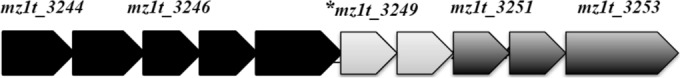
Physical map of the putative polysaccharide deacetylase genes located in the MZ1T EPS cluster (mz1t_3244, polysaccharide biosynthesis protein; mz1t_3245, hypothetical protein; mz1t_3246, lipopolysaccharide biosynthesis-like protein; mz1t_3247, asparagine synthase; mz1t_3248, family 2 glycosyltransferase; mz1t_3249, polysaccharide deacetylase; mz1t_3250, family 2 glycosyltransferase; mz1t_3251, hypothetical protein; mz1t_3252, family 2 glycosyltransferase; mz1t_3253, sulfatase [wbbL]).